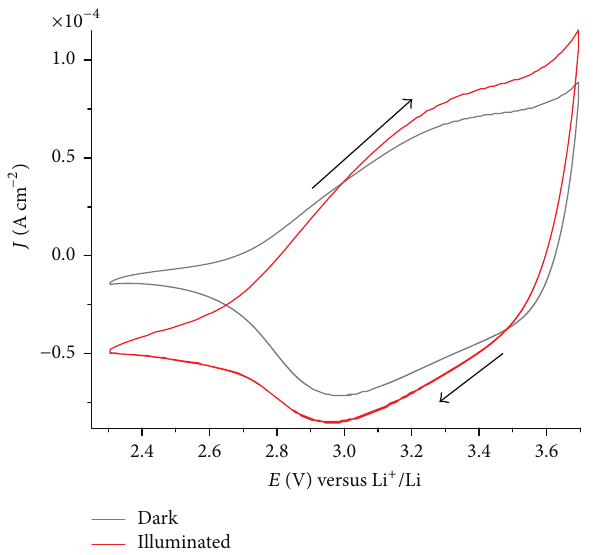
Figure 23: Comparison of the cyclic voltammograms of ERY- spray-deposited onto ITO in dark conditions sensitized RDS NiO x and under illumination. Both voltammograms have been recorded at the scan rate of 25mVs −1 . Profiles have been extracted from Figure 18(a) (dark conditions) and Figure 21 (illuminated state).